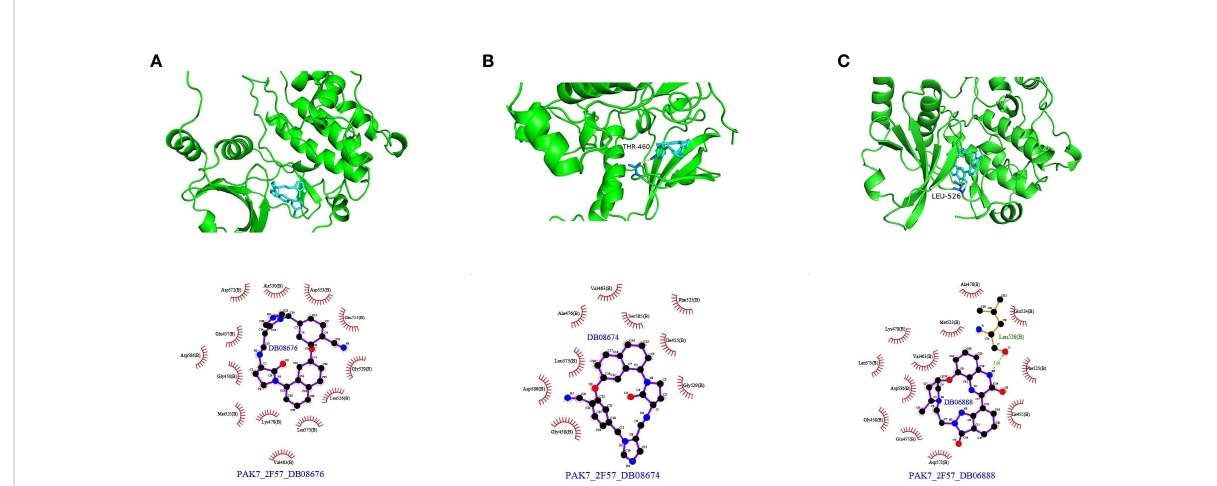
FIGURE 8 Docking conformation and interaction force analysis for PAK7 and three small-molecule compounds. (A) DB08676, (B) DB08674, and (C) DB06888. Top panel: Pymol shows the docking conformation and hydrogen bonding, wherein cyan is the small molecule, the yellow dashed line is the hydrogen bond, and blue is the amino acid residue forming the hydrogen bond with the small molecule. Bottom panel: Ligplus force analysis, wherein the small molecule is in the middle, surrounded by related protein amino acid residues; the green dashed line is the hydrogen bond; and the amino acid in green is the amino acid residue forming a hydrogen bond.